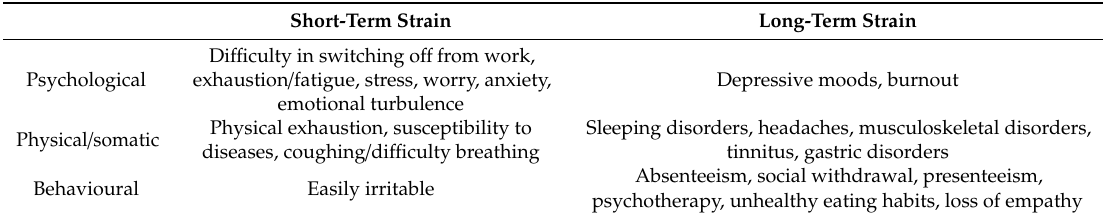
Table 6. Short-term and long-term strain experienced by